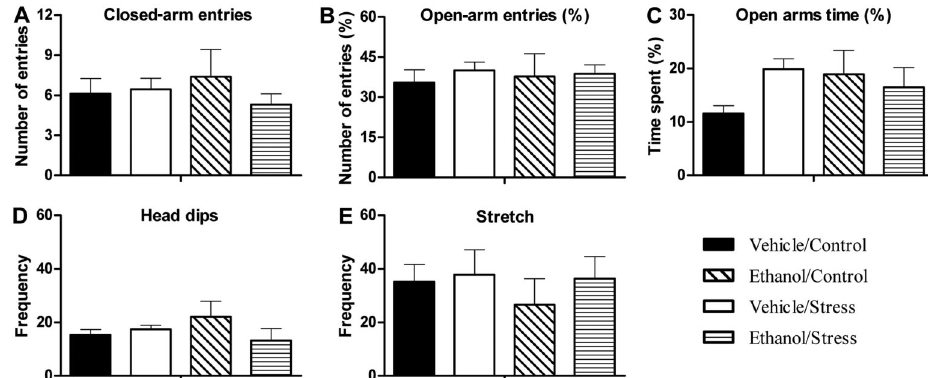
Figure 2. Spatial and ethologic behaviors of mice exposed to the elevated plus maze (EPM) after chronic administration of ethanol and stress testing. Mice were tested for 5 min after 12 h of ethanol withdrawal. Data are reported as means ± SE. A , Number of closed-arm entries; B , percentage of open-arm entries; C , percentage of time spent in open arms; D , number of head dips; E , number of stretch- attend postures. No signi fi cant differences were found for mouse behavior in EPM for n=8 – 10 animals per